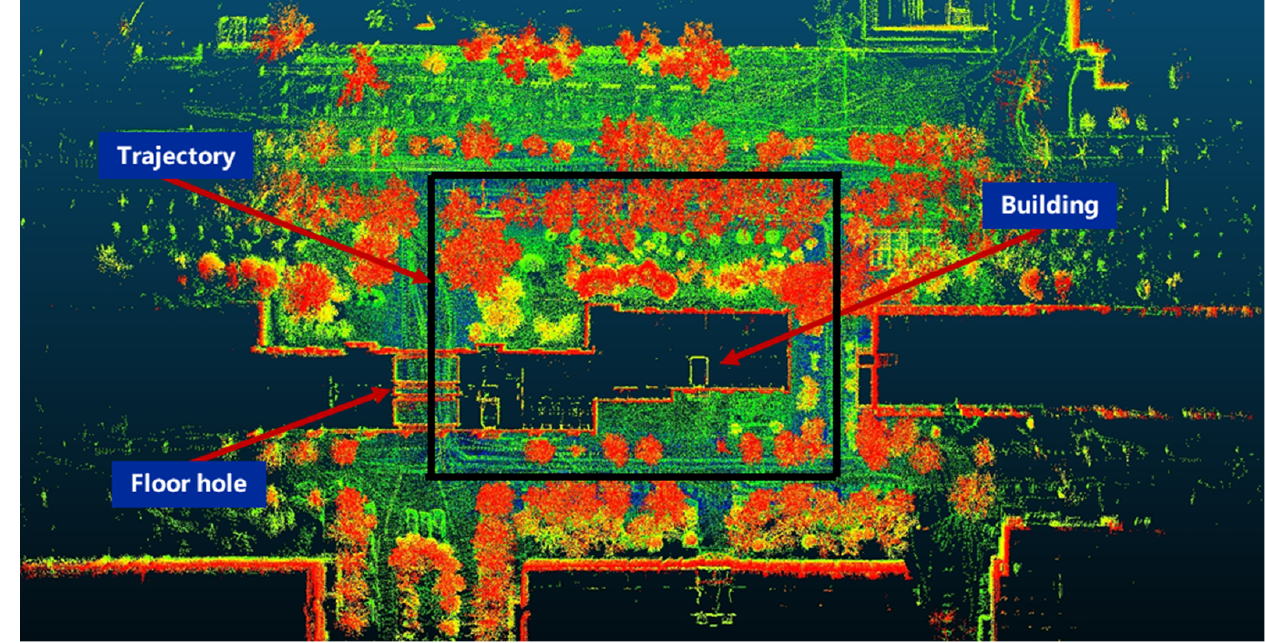
Figure 17. Three-Dimensional LiDAR global point cloud map in case two.